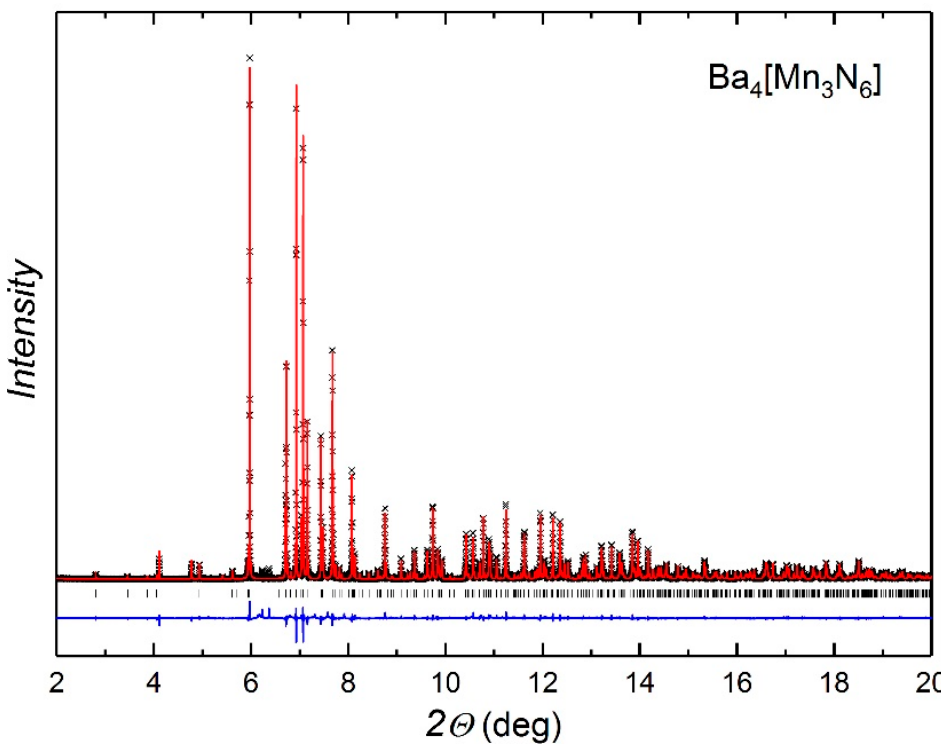
Figure 1. Synchrotron PXRD pattern of Ba 4 [Mn 3 N 6 ] ( λ = 0.35434 Å) with experimental points shown in black, calculated pattern after Rietveld refinement in red, and difference curve in blue. Tick marks denote the calculated positions of Bragg reflections. Table 1. Crystallographic Data and Experimental Details for Ba 4 [Mn 3 N 6 ] at 298 K.